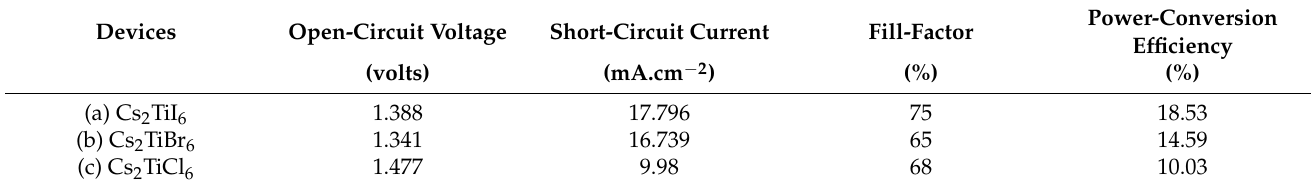
Power-Conversion Efficiency